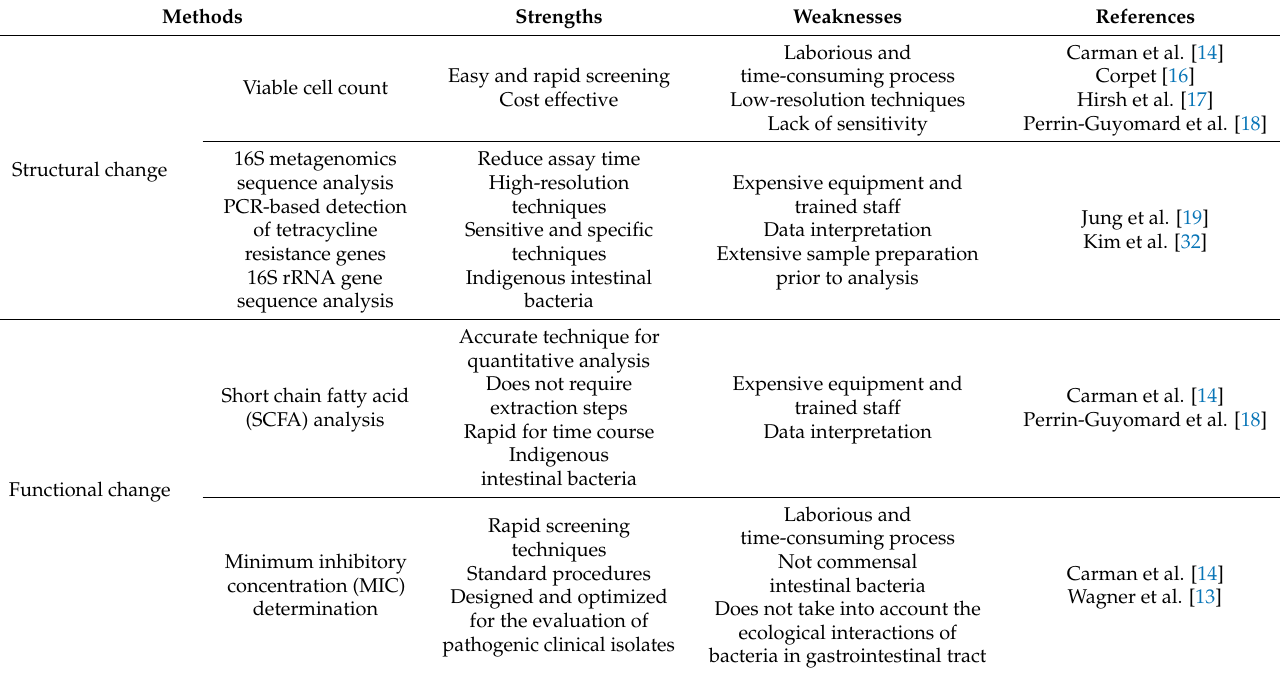
Table 1. Summary table of evaluating methods used in a continuous flow